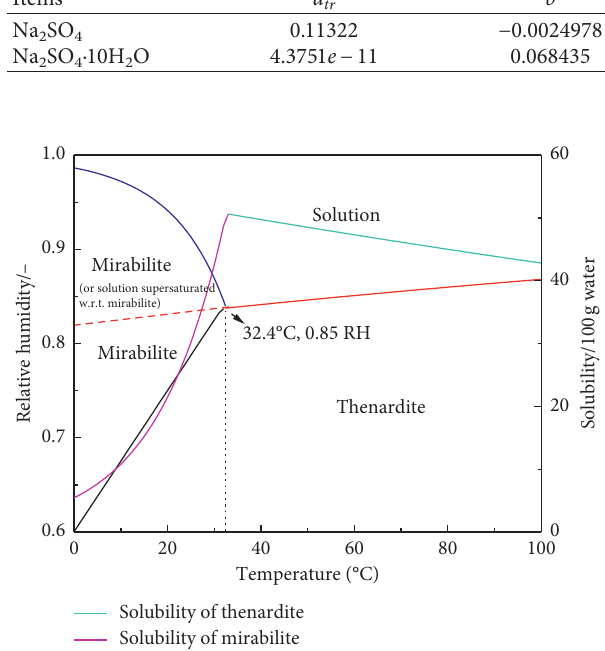
Figure 5: Phase spectrum and solubility of sodium